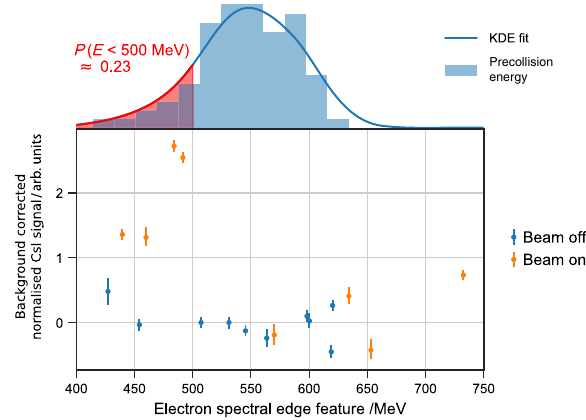
FIG. 5. The background-subtracted CsI signal as a function of the energy of the edge in the electron spectrum. The histogram on the top shows the distribution of electron beam energies recorded during a separate sequence of shots where no radiation reaction signal could occur. Overlaid is a kernel density estimate (KDE) to the distribution of electron beam